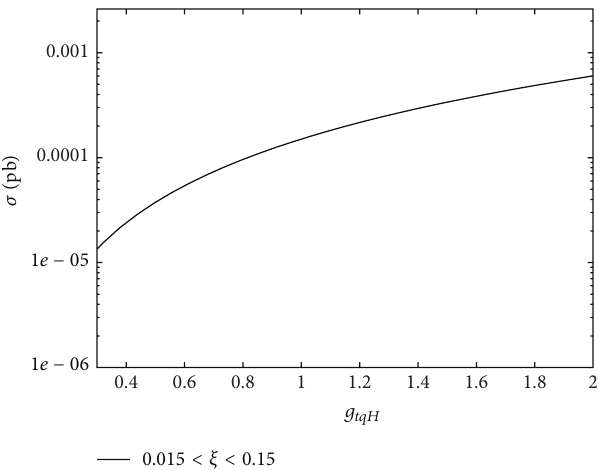
Figure 4: Total cross section of 𝑝𝑝 → 𝑝𝛾𝑝 → 𝑝𝑡𝐻𝑋 → 𝑏𝑏𝑋 as a function of anomalous coupling 𝑔 𝑝𝑏ℓ + ] ℓ detector acceptance is taken to be 0.015 < 𝜉 < 0.15